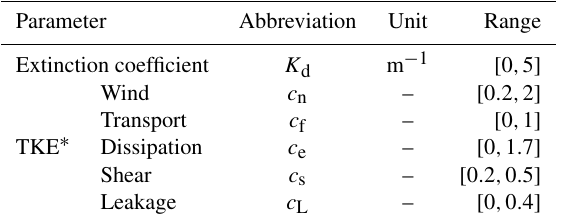
Table 1. Parameters of the Canadian Small Lake Model and their sampling ranges. Parameter Abbreviation Unit Range Extinction